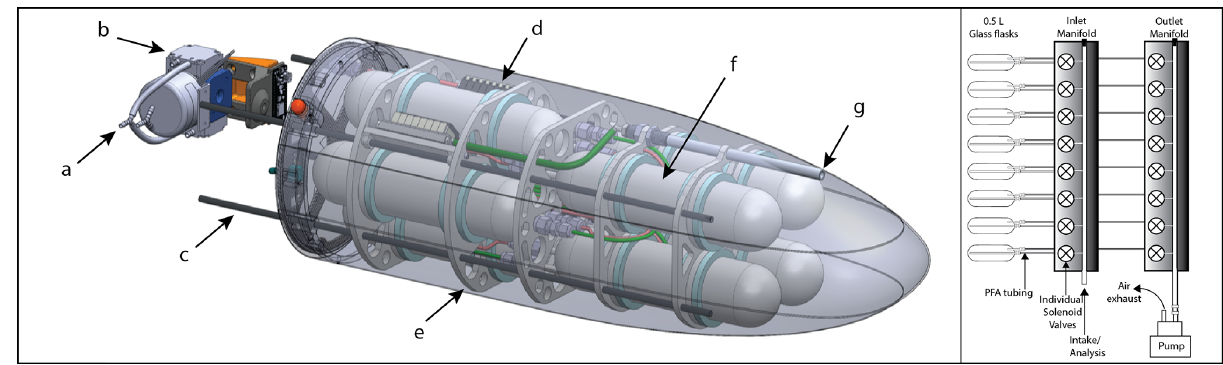
Figure 3. Left: overview of the custom nose cone sampling pod. (a) Air exhaust to outside the fuselage. (b) 8Lm − 1 KNF pump. (c) Supporting rods for payload connection to UAV fuselage. (d) Eight-port valve manifolds to inlet and outlet. (e) Nylon-12 baseplates with memory foam for flask suspension. (f) 500cm 3 glass flasks with a two-port dip tube. (g) Air intake. Right: schematic diagram of the same nose cone sampling pod, showing flow path of air from intake manifold, through flasks to outlet manifold and pump air